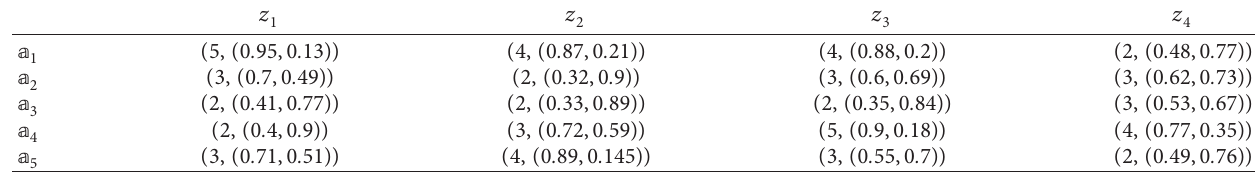
S defined from the problem proposed in Section 5.1. f